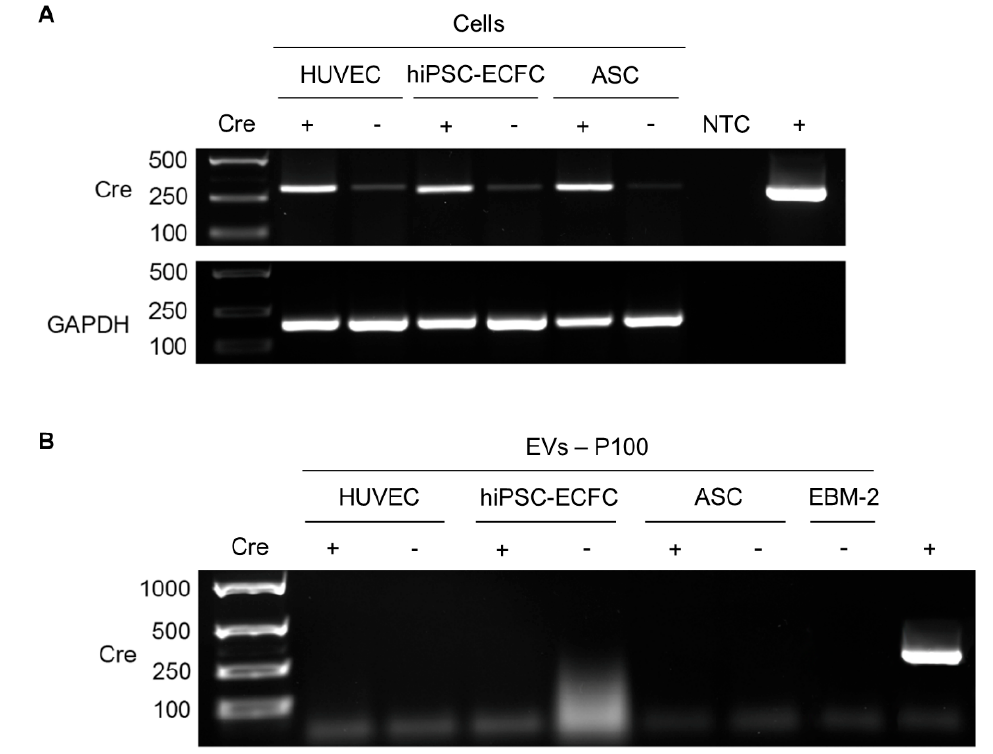
Figure 6. Test for Cre expression in the different cell types and extracellular vesicles (EVs) isolated via ultracentrifugation. ( A ) RNA isolated of the individual cell types retrovirally transduced with pBMN-Cre (Cre + ) was investigated in comparison to uninfected cells (Cre-) of the same type and donor. GAPDH expression was utilized as control. Furthermore, the plasmid pBMN-Cre was used as positive control (+) and H 2 O as a non-template control (NTC). ( B ) EVs released from Cre + and Cre − cells were obtained via ultracentrifugation (100,000 × g = P100) and inquired for carrying Cre mRNA. pBMN-Cre was used as positive control (+) and plain EBM-2 as negative control. n = 2 cell donors (HUVEC, ASC) and one donor (hiPSC-ECFC).